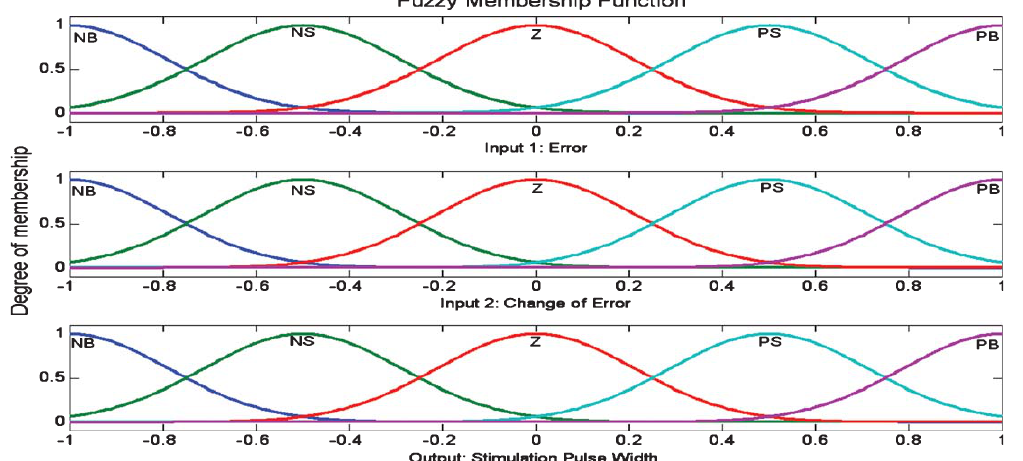
Fig. 5. Fuzzy membership